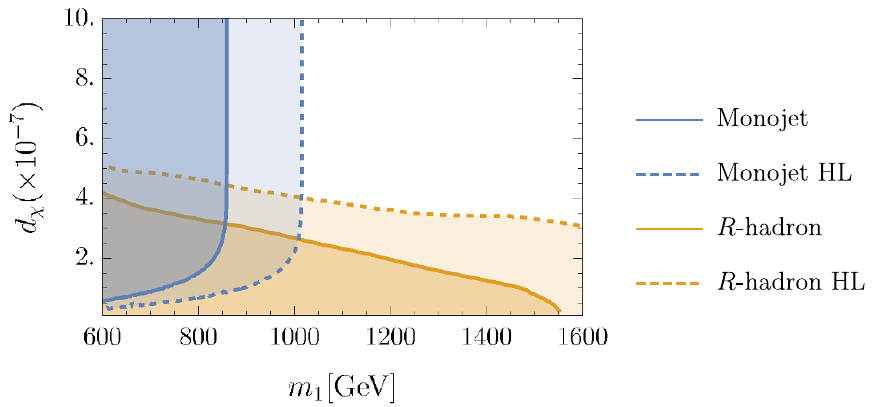
Figure 6 . Current (solid) and foreseen future (dashed) status of the parameter space as excluded by monojet and R -hadrons searches, in blue and orange, respectively. The mass splitting (cid:1) m is (cid:12)xed, for given m 1 , by the relic density as shown in (cid:12)gure 1. The assumptions made regarding the scaling of the error at high luminosity can be found in the